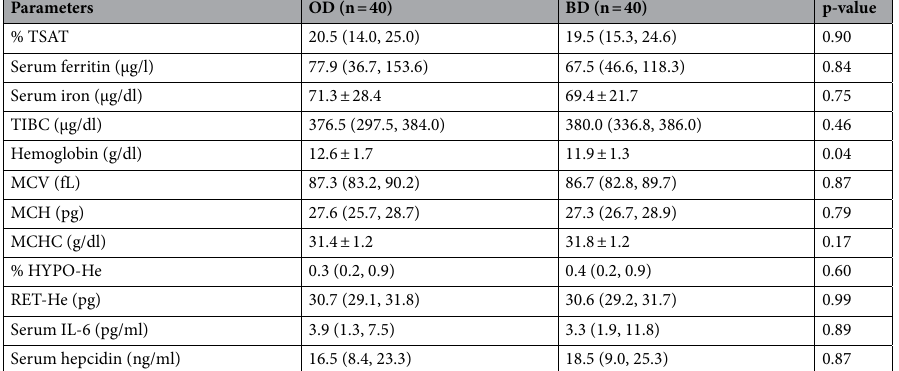
Table 2. Baseline hematological and biochemical parameters in the study participants. Data presented as mean ± standard deviation or median (25th, 75th percentile) as appropriate. Compared using the Mann–